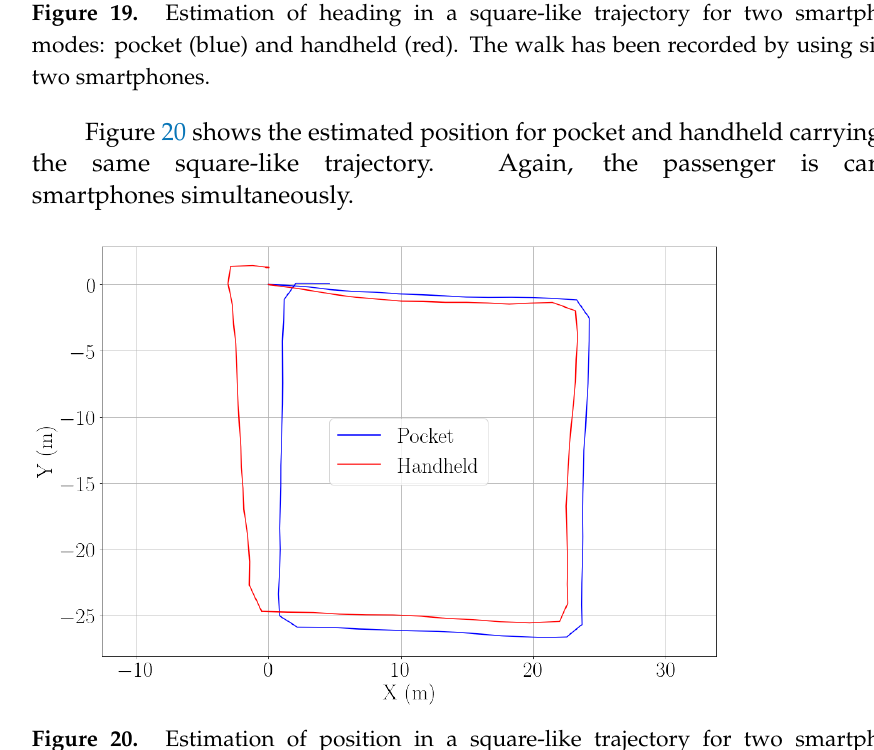
Figure 20. Estimation of position in a square-like trajectory for two smartphone carrying modes: pocket (blue) and handheld (red). The walk has been recorded by using simultaneously two